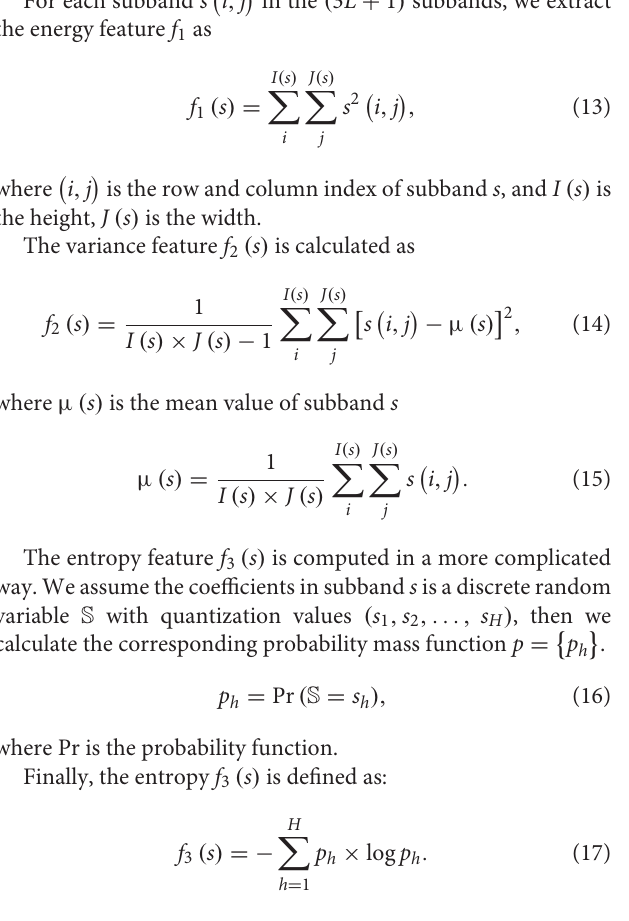
developed a wavelet variance-based method for modeling sensor error. Inspired by those three papers, we propose the extraction of triple features based on wavelet